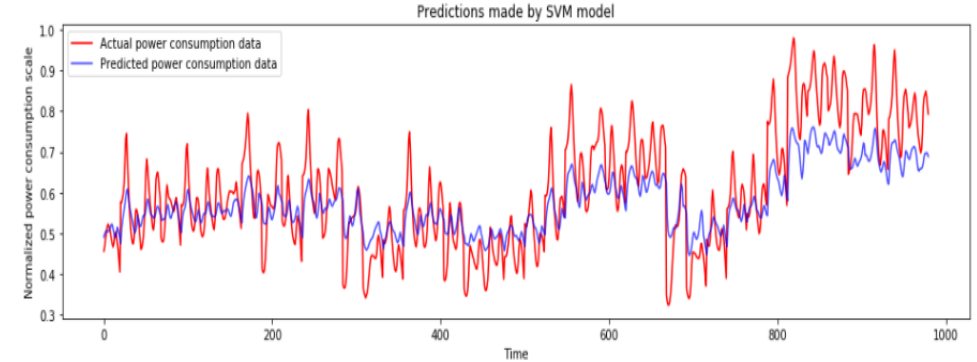
Figure 8. Forecast result of support vector model with respect to test dataset over time (day).